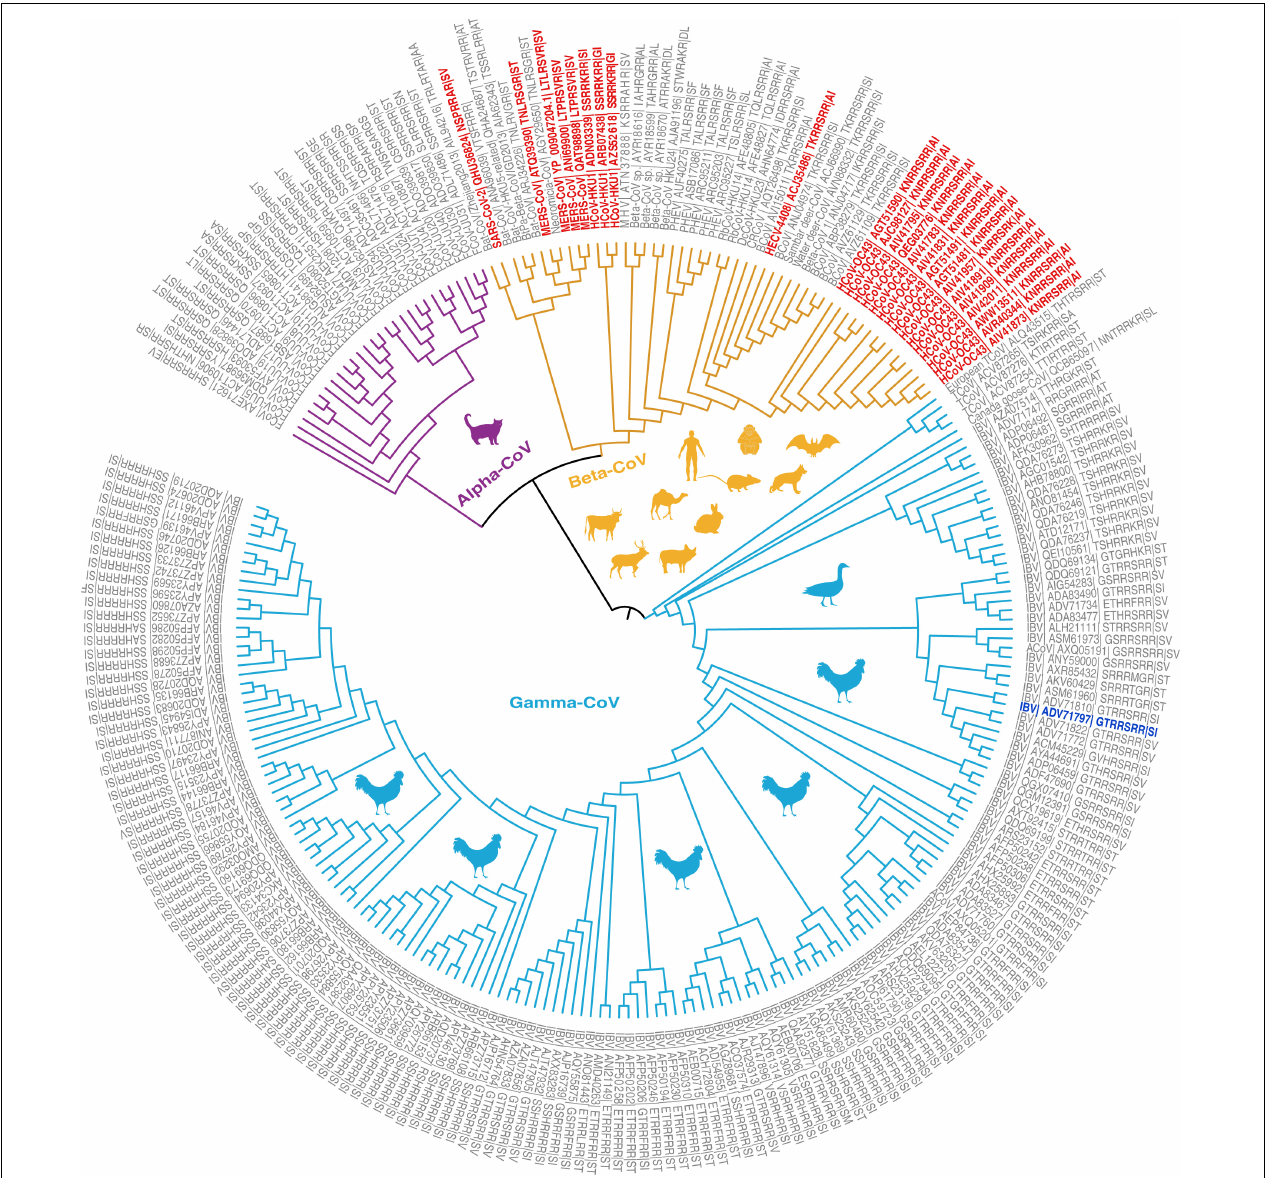
FIGURE 1 | Phylogenetic relationships of coronavirus spike proteins with furin cleavage sites. For information regarding the proteins (see Supplementary Tables 1 , 2 ). The branches are colored according to virus genus (purple = Alpha-CoV, yellow = Beta-CoV, light blue = Gamma-CoV). Animal shapes indicate the viruses’ main hosts and are colored according to the genus of virus they host. The leaves show the virus species, GenBank Accession numbers, and furin cleavage site motifs. Four coronaviruses with furin cleavage sites known to infect humans (HCoV-OC43, HCoV-HKU1, MERS-CoV, and SARS-CoV) and a human enteric coronavirus 4408 (HECV-4408) first detected in Germany in 1988 are marked in red. The first recorded coronavirus with a furin cleavage site was detected in Gallus and is marked in blue.